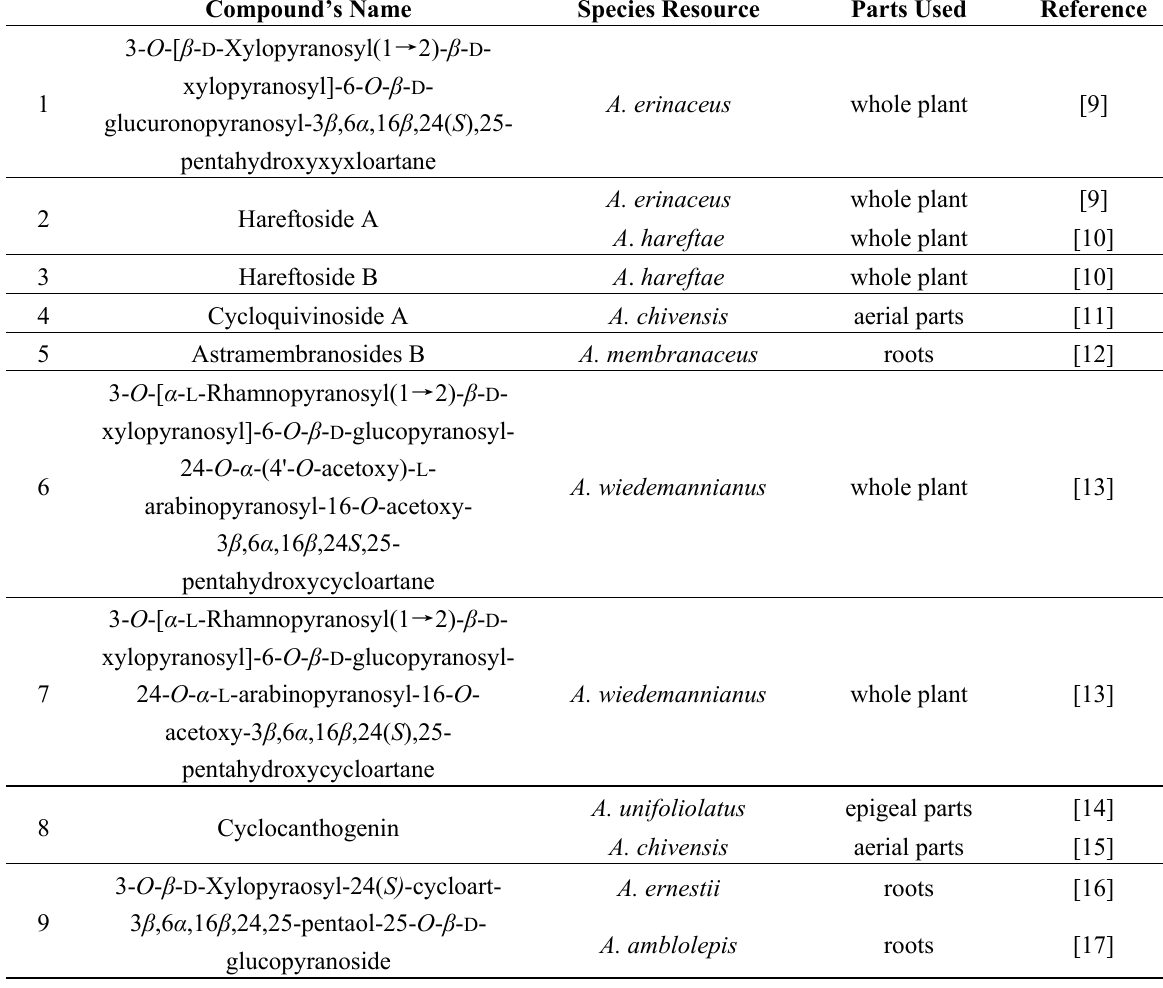
Table 1. Cycloartane-type triterpenoids from the Astragalus genus ( 1 – 142 ). Compound’s